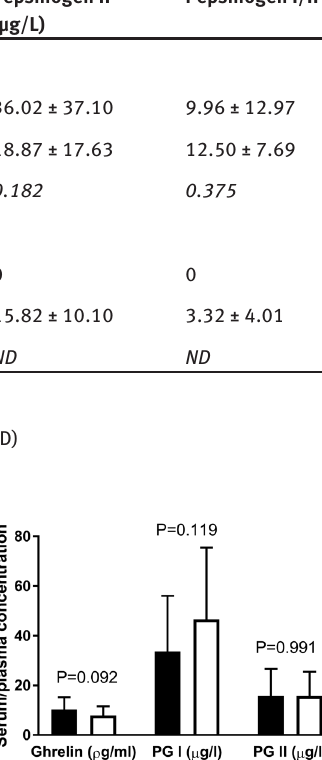
Table 2: Plasma levels of ghrelin and serum levels of pepsinogen I, II, and their ratio based on alcohol consumption. Variables